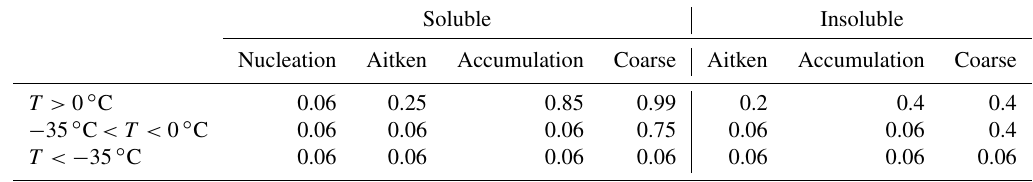
Table 1. In-cloud scavenging efficiency factors used in the wet deposition scheme. Values are adapted from Bourgeois and Bey (2011). Soluble